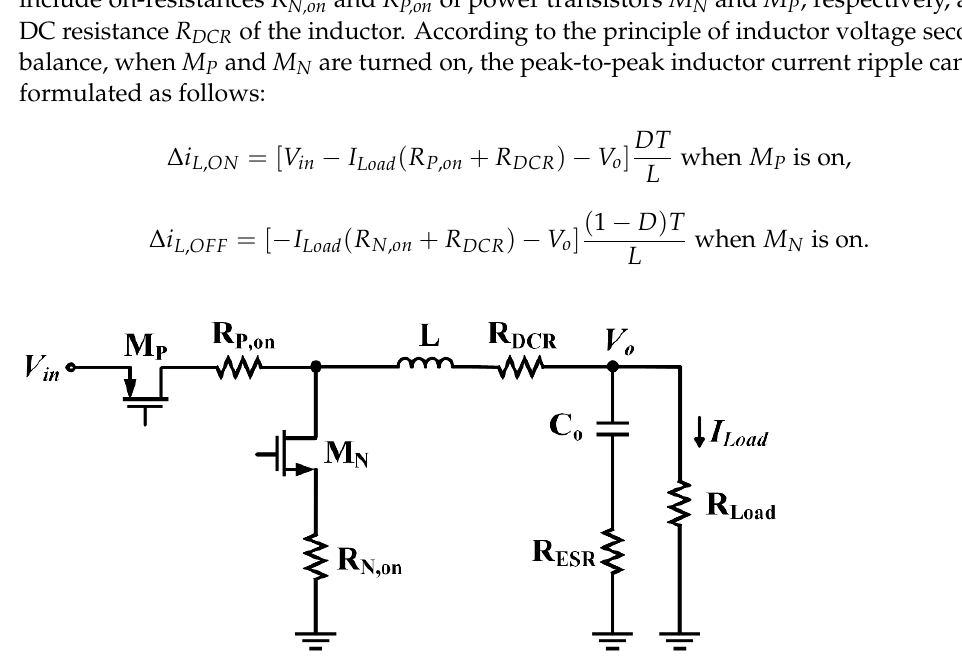
Figure 4. Block diagram of adaptive on-time (AOT) buck converter with wave tracking reference (WTR) control.